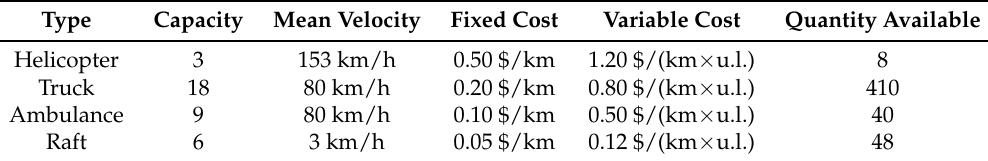
Table 1. Characteristics of available vehicles.